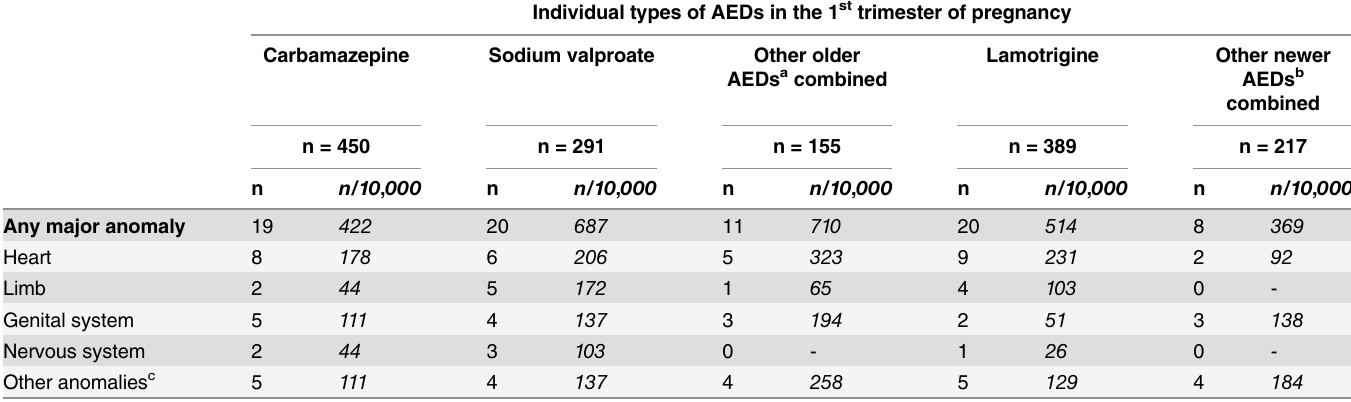
Table 4. Absolute risks (per 10,000 children) of major congenital anomalies in children according to type of antiepileptic drug in the 1 st trimester of pregnancy. Individual types of AEDs in the 1 st trimester of